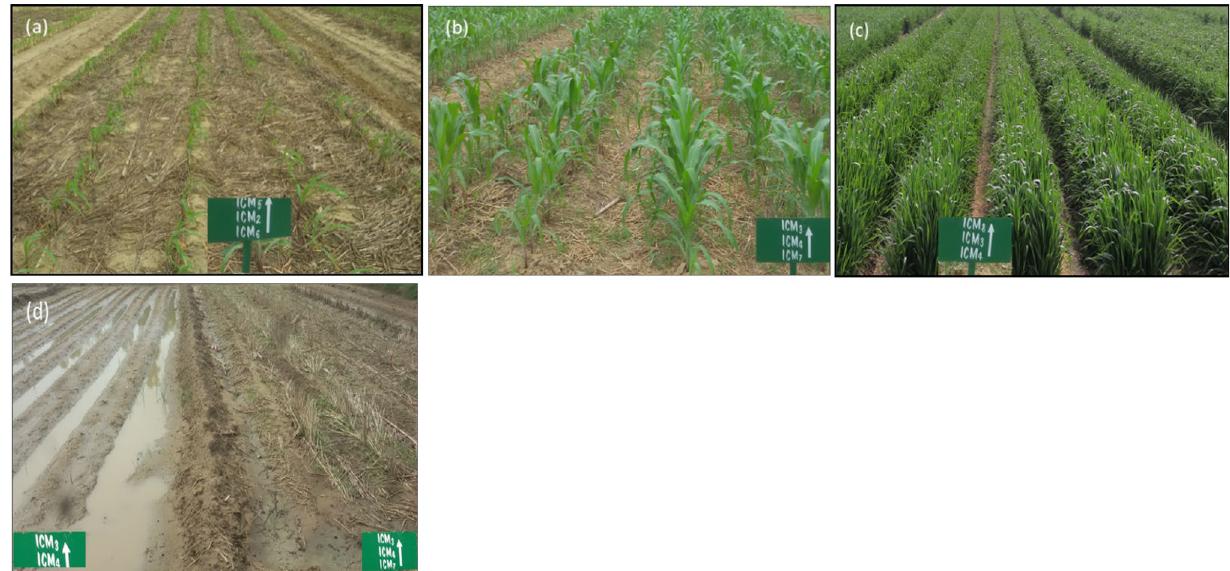
Figure 6. Initial establishment of ZT maize under residue retained CA-based ICM 6 ( a ); 27 d old maize under CA-based